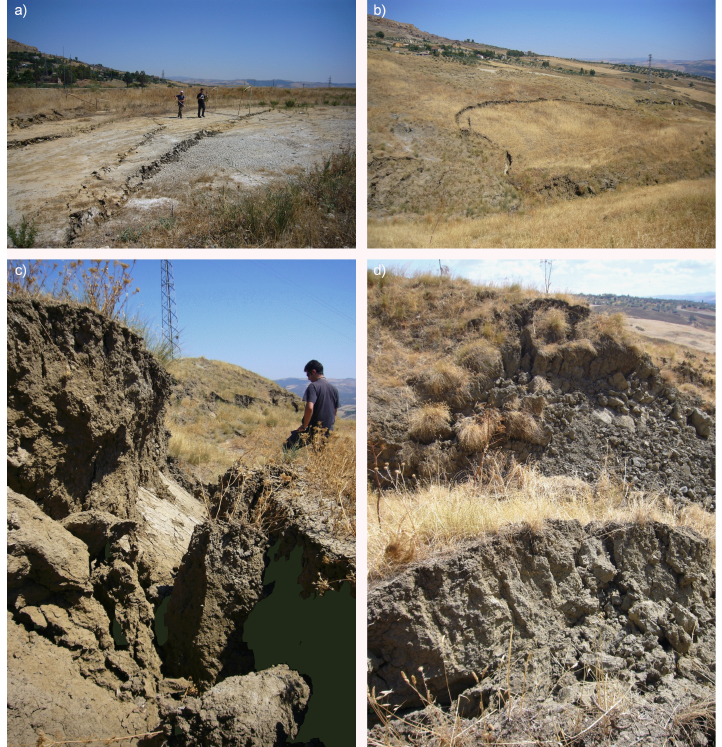
Fig. 7. Details of the fracture network originated from the 11 August 2008 event: (a) simple cracks with centimetric displacements associated to features of higher dimensions in the immediate surroundings of the vents; (b) portions of slopes cut by discontinuities with both horizontal and vertical movements; (c) particular of the previous rupture line; (d) brecciation of the clay deposits at the foot of the steepest slopes in the southern boundary of the studied